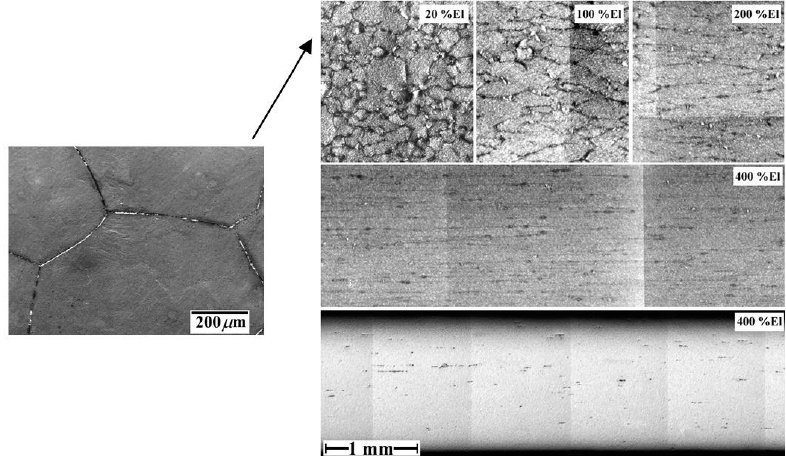
Figure 11. Correlation between the rotation of FαBs during superplastic flow and the formation of cavity